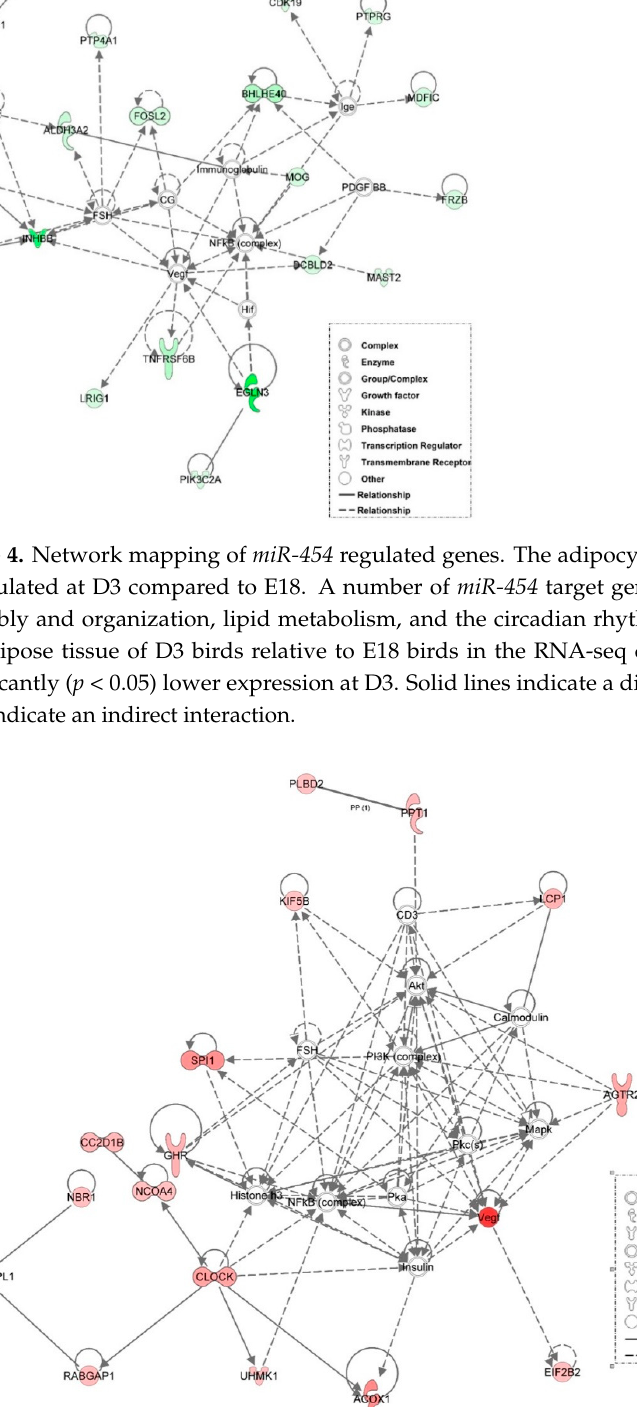
Figure 5. Network mapping of miR-15a target genes. From E18 to D3, the adipocytic expression of miR-15a declined. Network mapping of miR-15a upregulated (from E18 to D3) target genes in the adipocytic transcriptome data, identifying a group of targets associated with organismal development and the circadian rhythm. Red molecules had significantly ( p < 0.05) higher expression at D3. Solid lines indicate a direct interaction and dashed lines indicate an indirect interaction.